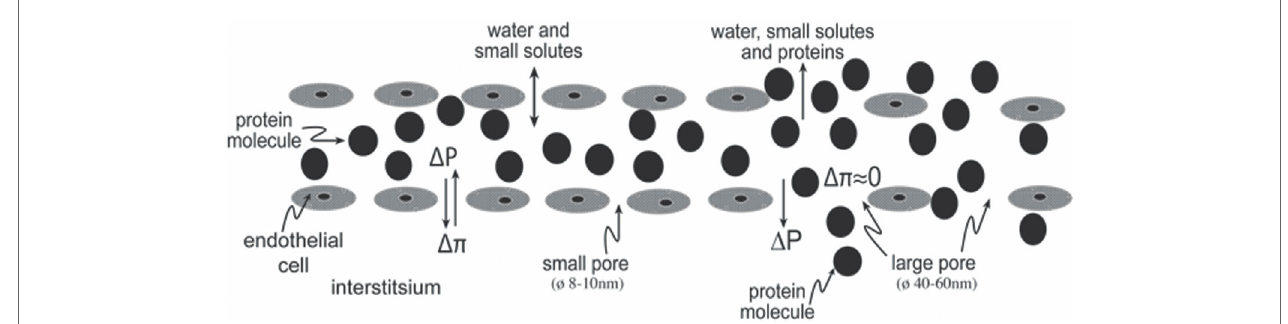
FiGURe 7 | Transcapillary fluid exchange across a capillary outside the brain, according to the 2-pore theory. The illustration shows the large number of small pores across the whole capillary membrane that are permeable only to water and small molecules, such as electrolytes, and the much fewer large pores at the end of the capillary network and in venules, which are also freely permeable to proteins. No erythrocytes are shown. Due to the same oncotic pressure on both sides of the large pores, there is no oncotic absorbing force across the large pore ( Δπ = 0). This means that the transcapillary hydrostatic pressure ( Δ Pc) is the only force across the large pores, creating a convective protein-rich volume flow through them. This passive transcapillary volume flow will increase after an increase in arterial pressure, increasing the risk of protein loss and hypovolemia. There will be an increase in the number of large pores after trauma, which will increase the transcapillary loss of proteins. This theory means that protein loss is a passive mechanism, mainly through convection. For details, see Ref. (88). Partly reproduced from Ref. (8) with